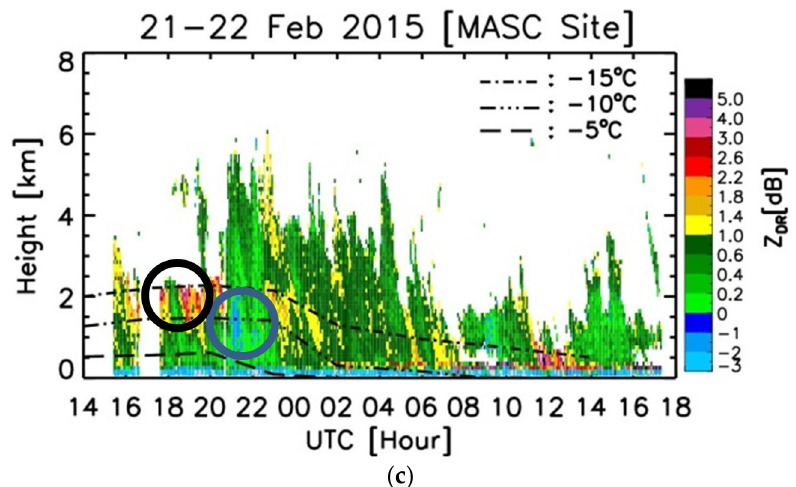
Figure 29. ( a ) RHI scan display from the CSU-CHILL radar at 21:30 UTC on 21 February 2015; ( b ) Horizontal reflectivity, Z h , height-time indicator above the MASCRAD Field Site, extracted from RHI scans during the 21–22 February 2015 event; ( c ) Differential reflectivity, Z dr , height-time indicator for the event; blue and black circles indicate negative Z dr and high Z dr ( Z dr > 3 dB) regions, respectively.